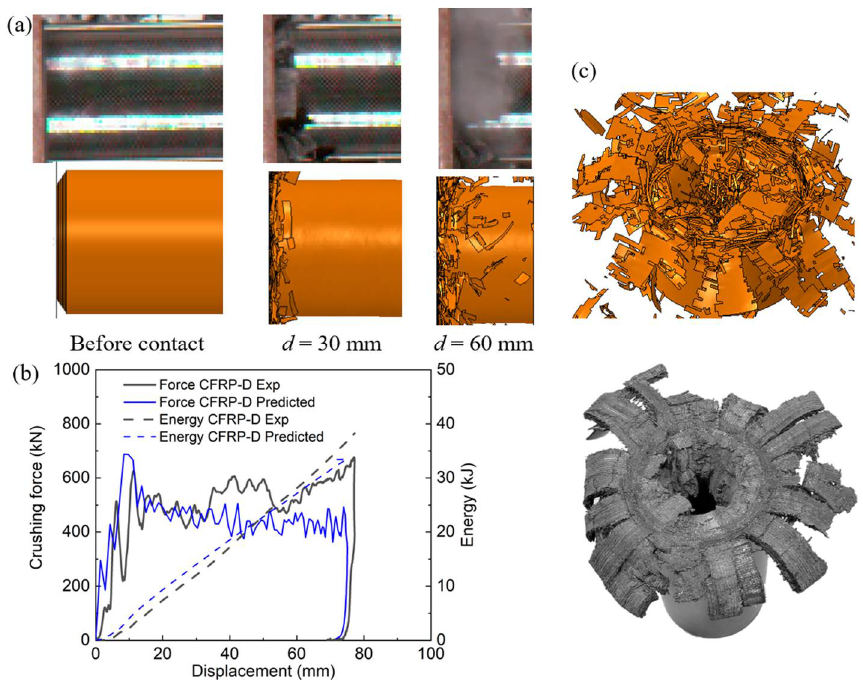
Figure 13. Comparison of the experimental and simulated results of the composite tube: ( a ) crushing process, ( b ) crushing force–displacement and energy–displacement curves, and ( c ) failure modes.